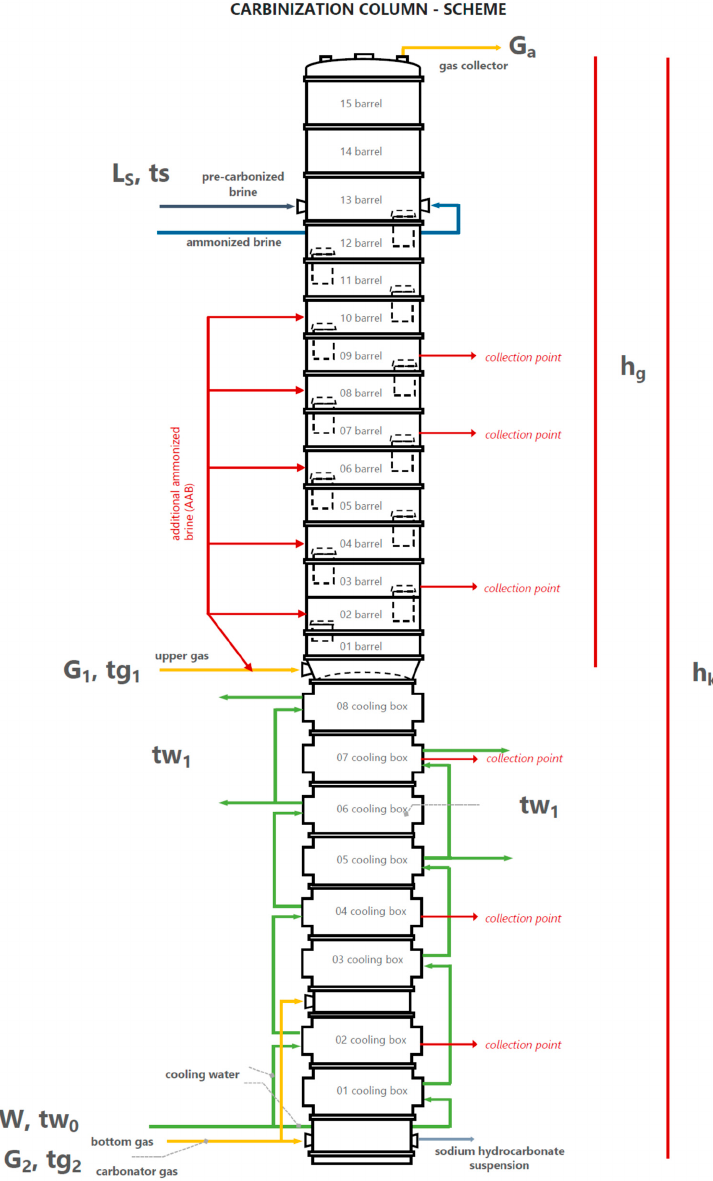
Figure 3. Production/research scheme of the carbonization column.